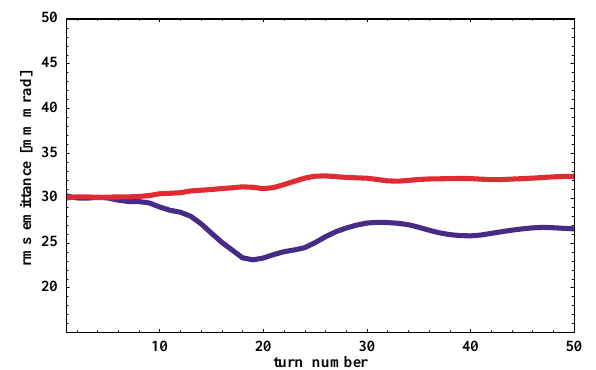
FIG. 6. (Color) rms emittances of a KV beam for ˜ N (cid:1) 7.3 . Vertical emittance is shown in red (upper curve) while horizontal emittance is shown in blue (lower curve).